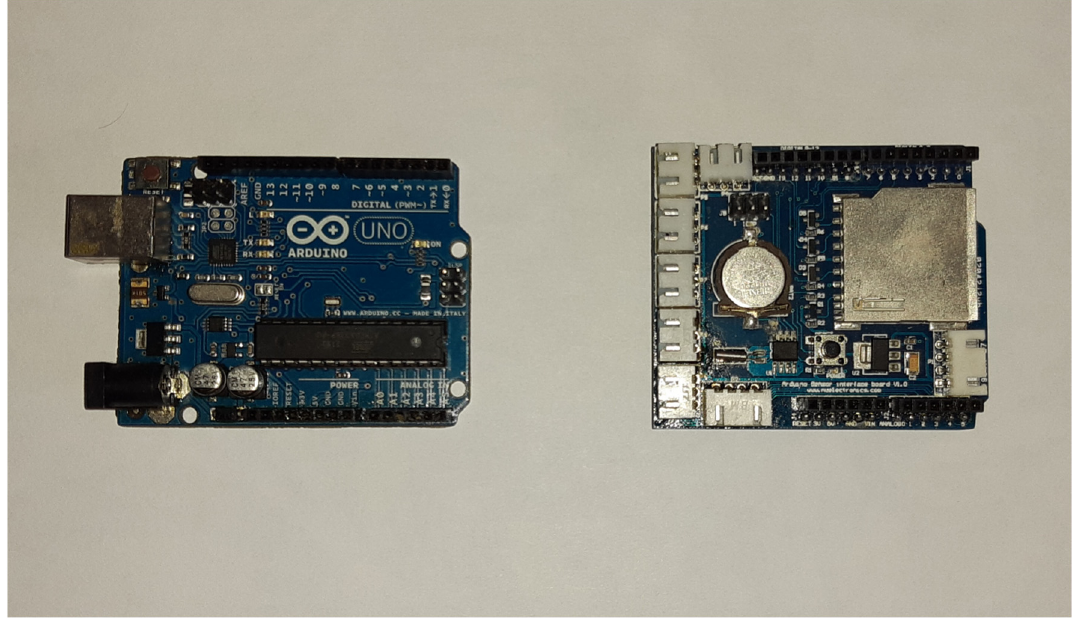
Figure 16. Arduino UNO card and Shiel SD Nuelectronics card (from Nuelectronics.com, accessed on 1 January